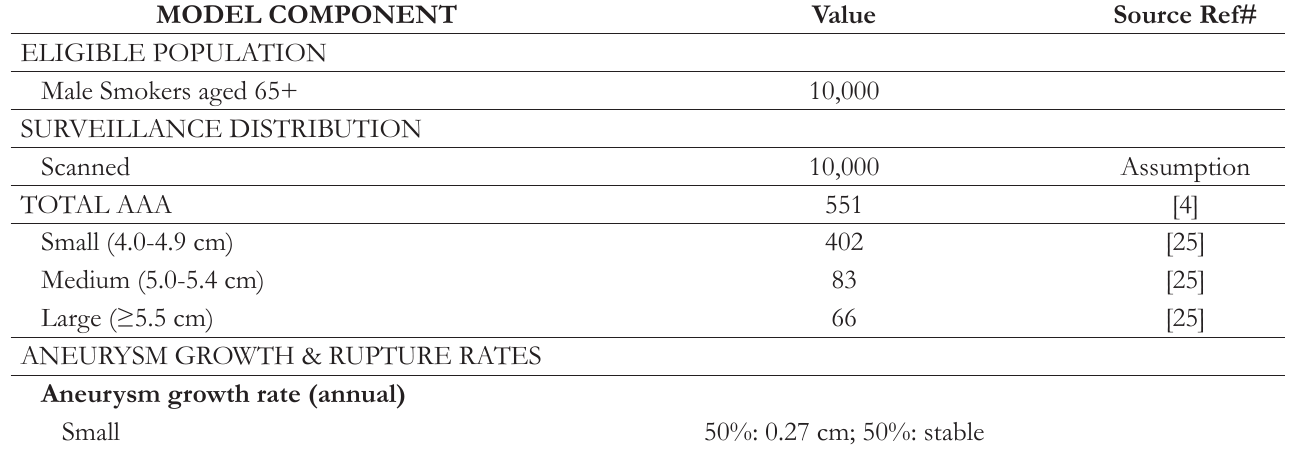
Table 1. Model Inputs and Values MODEL